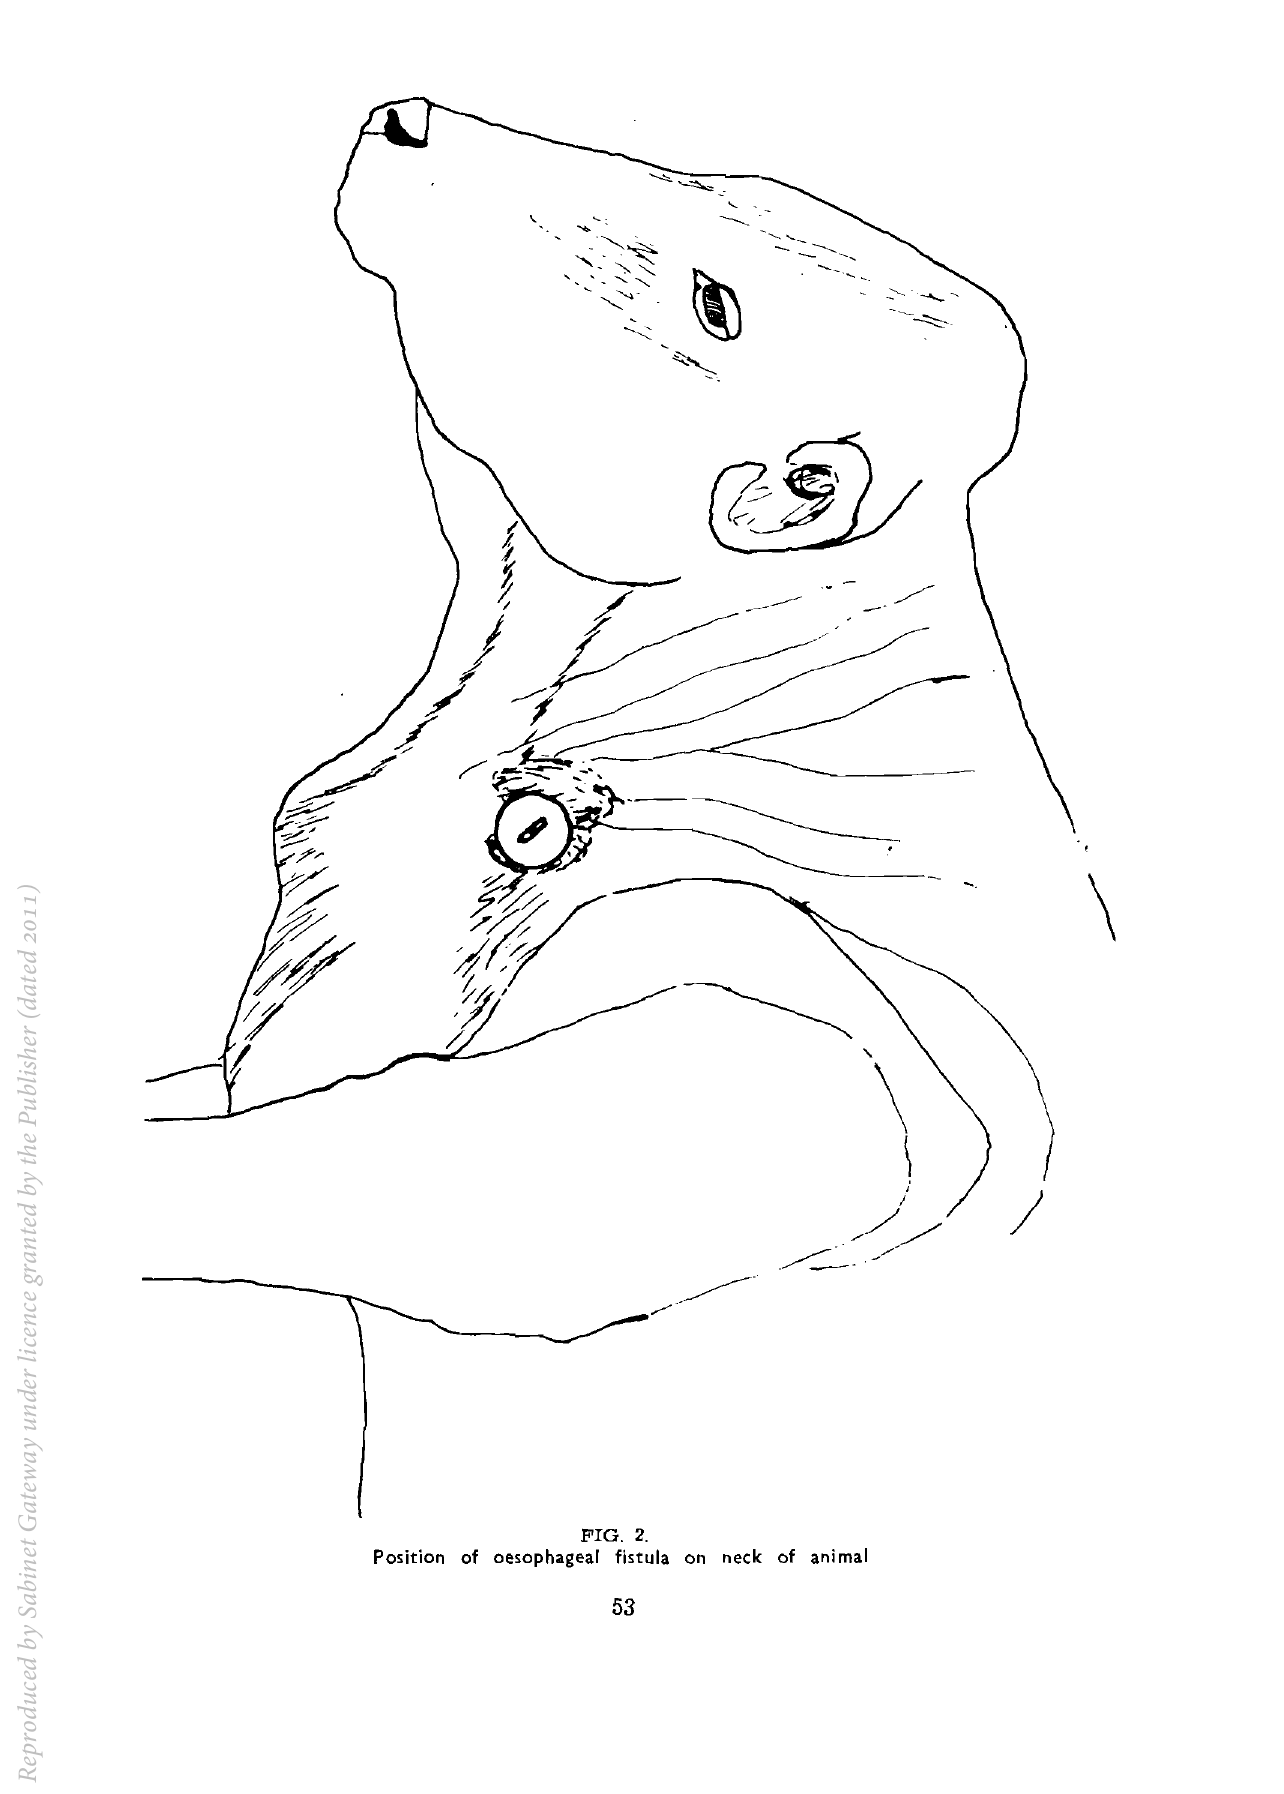
FIG. 2. o oesophageal fistula on neck of animal